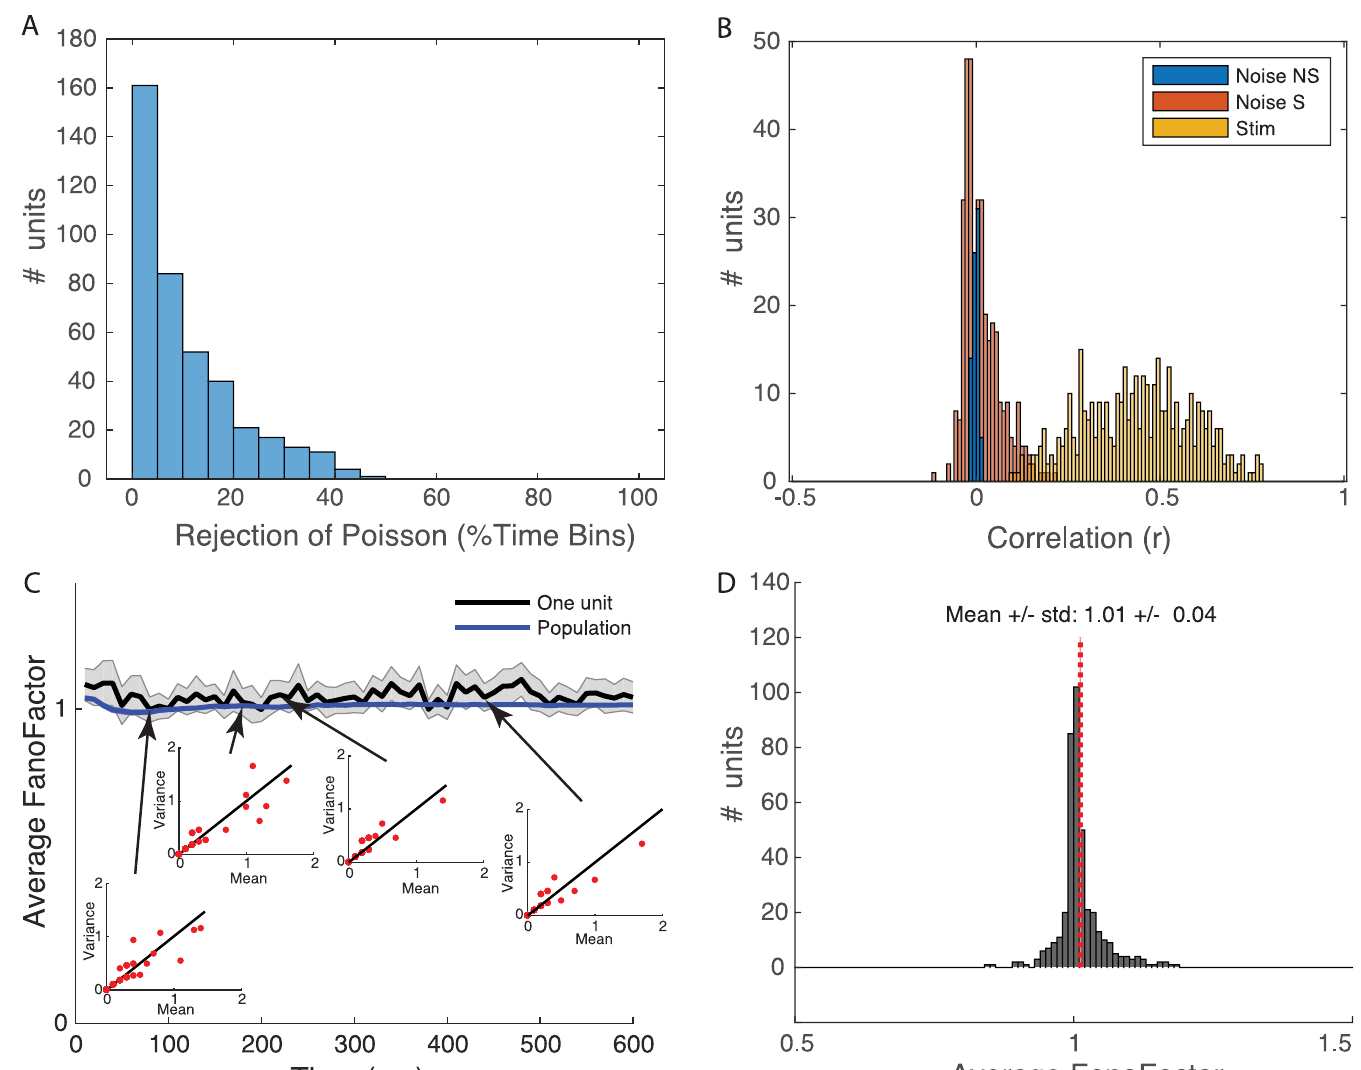
Fig 2. Poisson statistics. A . Distribution in number of neurons (n = 404) of the proportion of time bins where the Poisson assumption can be rejected. B . Distribution of the values of stimulus correlation (yellow) and noise correlation in pairs of successive time windows for the neural population (n = 404). Noise correlation values are represented in a stacked histogram depicting values significantly different from zero in red and non-significant values in blue. C . Time-varying Fano Factor (Variance/ Mean) obtained from the empirical distribution of spike counts estimated in successive 10 ms windows. Spike count distributions are obtained from 10 trials and the average Fano Factor from repeating the estimation of mean and variance calculation for all stimuli presented (min = 54, max = 104). The Fano Factor is shown for one example neuron (solid black line) and also averaged across the entire population (n = 404). Error bars are ± two SEMs. The insets show the mean and variance spike count for the example neuron at a given time shown by the arrows. On those plots, each red dot corresponds to one stimulus (many points overlap). D . Distribution of time averaged Fano Factors for the population of neurons (n = 404). Fano Factors are not significantly different from 1.